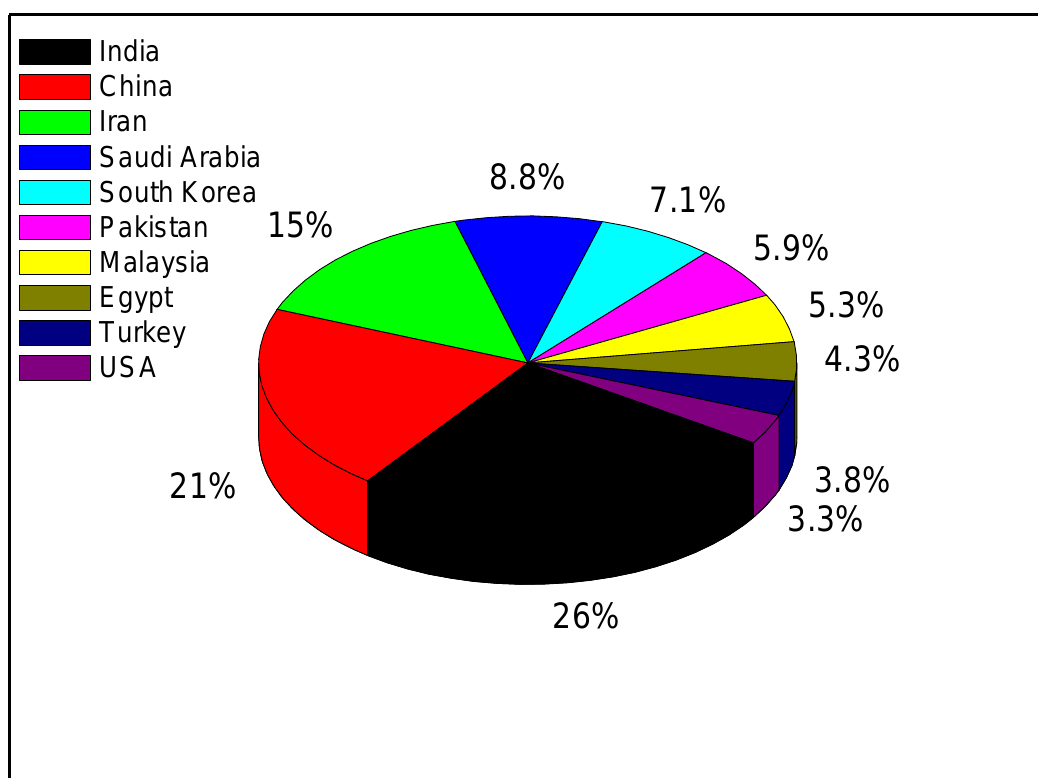
Figure 2. Leading countries in the study of photocatalysis for ZnO. As of 7 July 2022. Various countries have taken the lead in terms of the photocatalytic activity of ZnO (Figure 3). For example, India is the leading country in terms of the ZnO photocatalysis. The main reason why India is leading in terms of the photocatalysis of ZnO is because of the need to clean their wastewater to accommodate their high population needs. The pressure comes from their population, which is estimated to reach ~1.5 billion by 2050, with the projection that 50% of the total population is expected to be in urban areas [19]. An increase in urbanization will trigger more water usage, as a result, the need for the treatment of wastewater. There are other reasons as to why ZnO nanoparticles are favored over others. For example, ZnO has been chosen because of its wide band ( viz. 3.37 eV) and